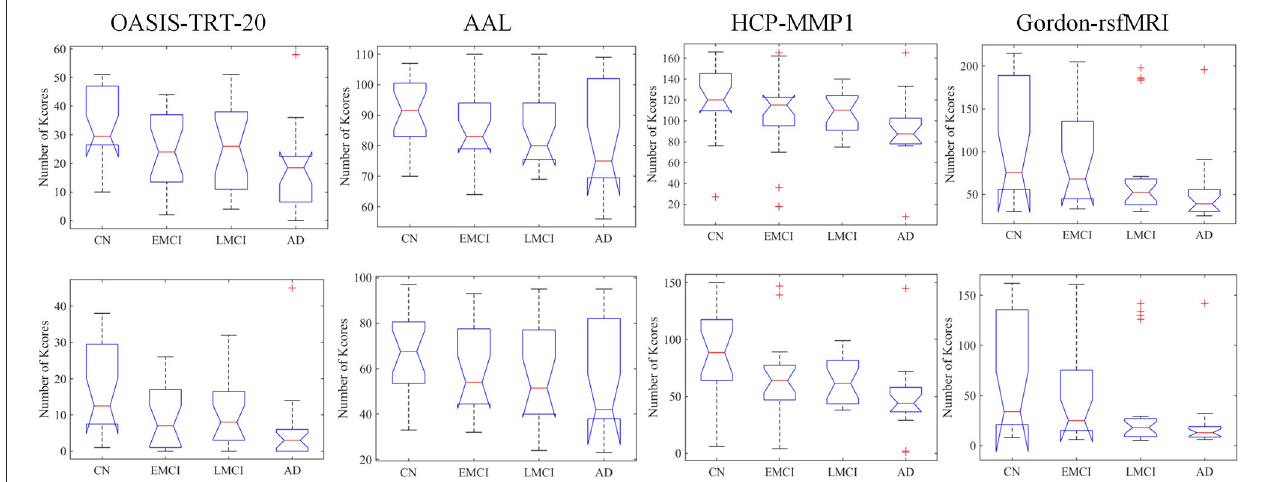
FIGURE 3 | Group median and interquartile ranges of k -core network nodes for each group, typically at the thresholds of k = 20 and k = 30. P -values derived from Kruskal-Wallis tests assessing SC topological differences among NC, EMCI, LMCI, and AD for each parcellation scheme are reported in Table 4 .